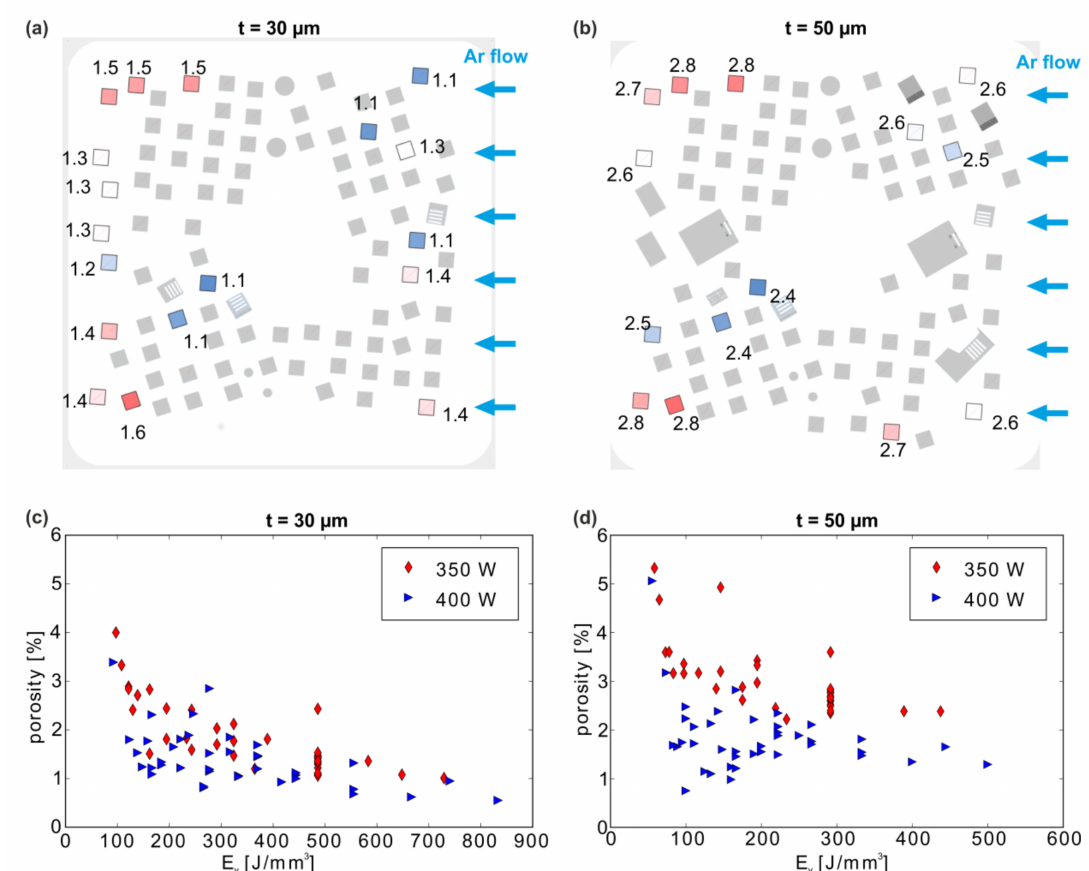
Figure 2. ( a ), ( b ): Reproducibility study: the distribution of nominally identical specimens (P = 350 W, v = 300 mm / s, h = 80 µ m) on the base plate for two build jobs with di ff erent layer thicknesses t with resulting porosities, rounded to 1 decimal [%] (red color indicates higher, blue lower porosity). ( c ), ( d ) Porosity of all tested specimens from both build jobs vs. the volume energy